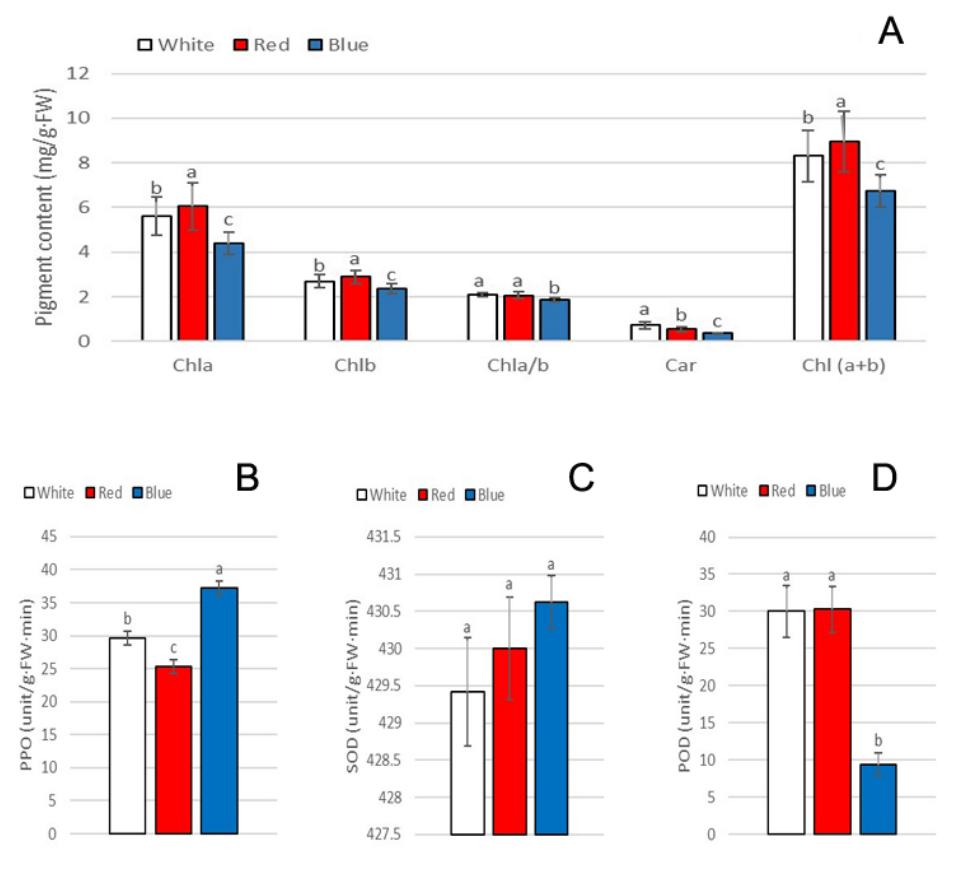
Figure 2. Responses of physiological processes in C. oleifera leaves under different light qualities. ( A ) Influences of different light qualities on photosynthetic pigment content in C. oleifera leaves. ( B ) Influences of different light qualities on polyphenol oxidase (PPO) content in C. oleifera leaves. ( C ) Influences of different light qualities on superoxide dismutase (SOD) content in C. oleifera leaves. ( D ) Influences of different light qualities on peroxidase (POD) content in C. oleifera leaves.